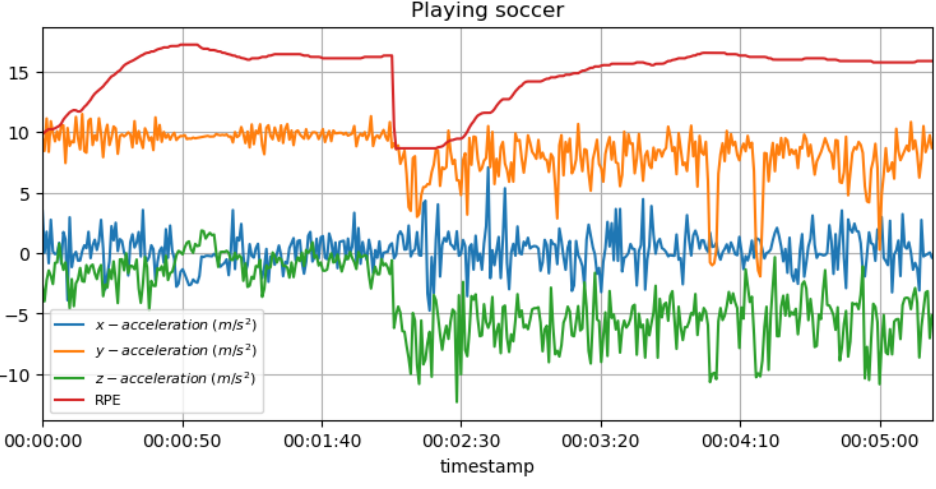
Figure 14. RPE for football activity with acceleration